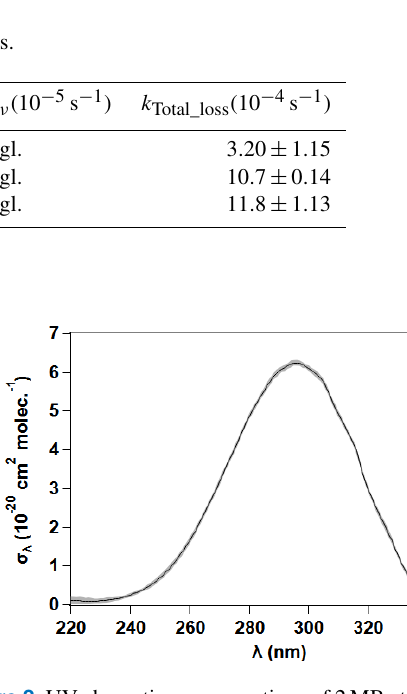
Figure 2. UV absorption cross sections of 2MB at 298K. The grey shadow represents the statistical